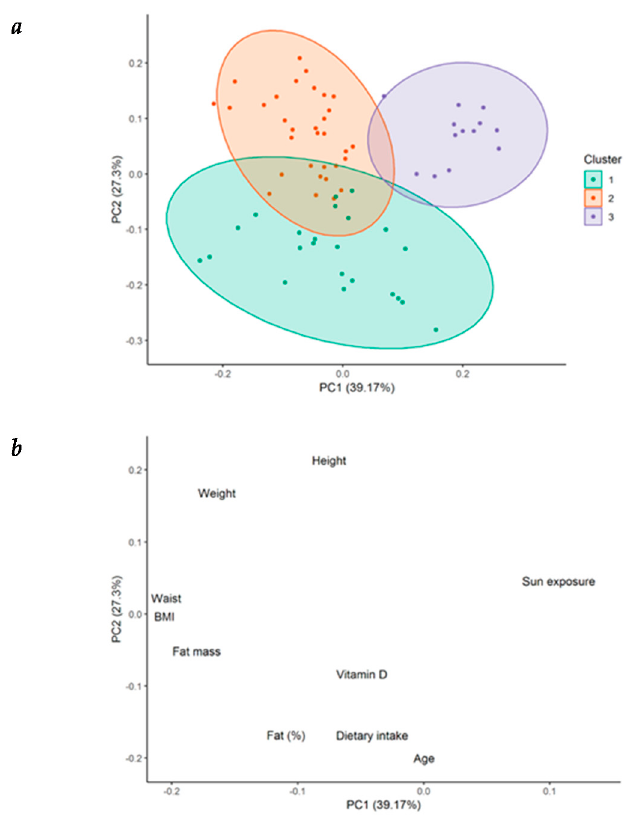
Figure 2. Cluster partitioning in patients with heart failure. ( a ) Cluster partitioning and its graphical representation of the principal component analysis (PCA) in patients with heart failure (HF); ( b ) graphical representation of the contribution of each individual variable to the variance of the PCA. BMI = body mass index.